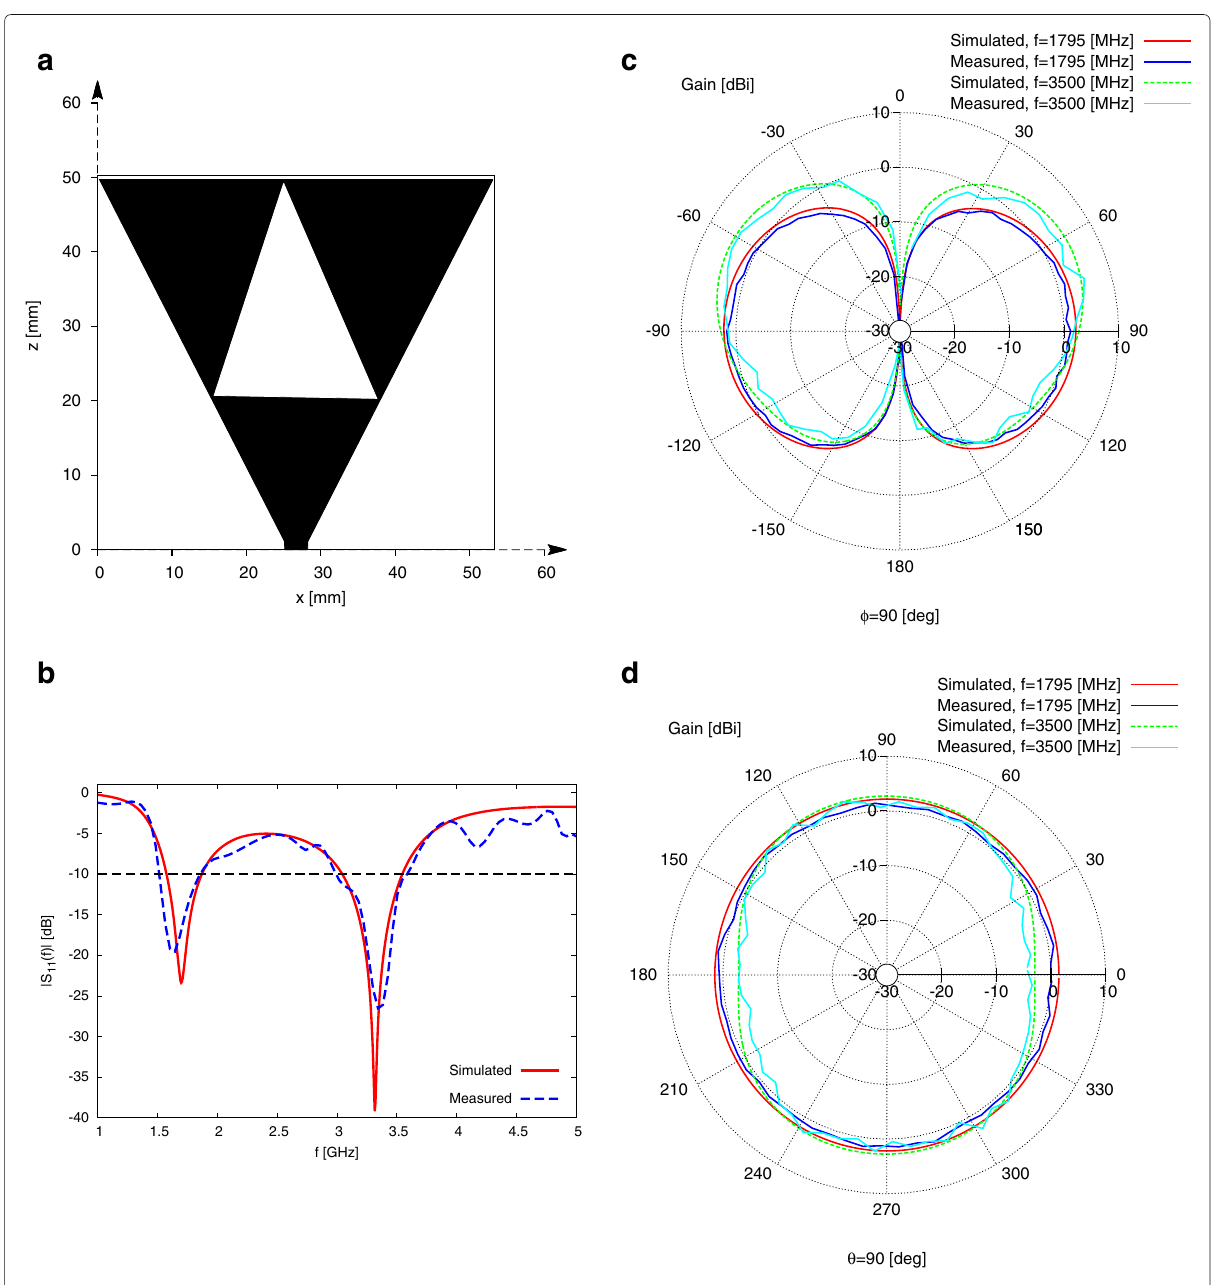
Fig. 8 SbD validation (LTE-1800 and LTE-3500 bands). Front view of optimized layout ( a ). Simulated/measured behavior of associated scattering parameter ( b ) and radiation patterns at 1.795 GHz and at 3.5 GHz when c ϕ = π